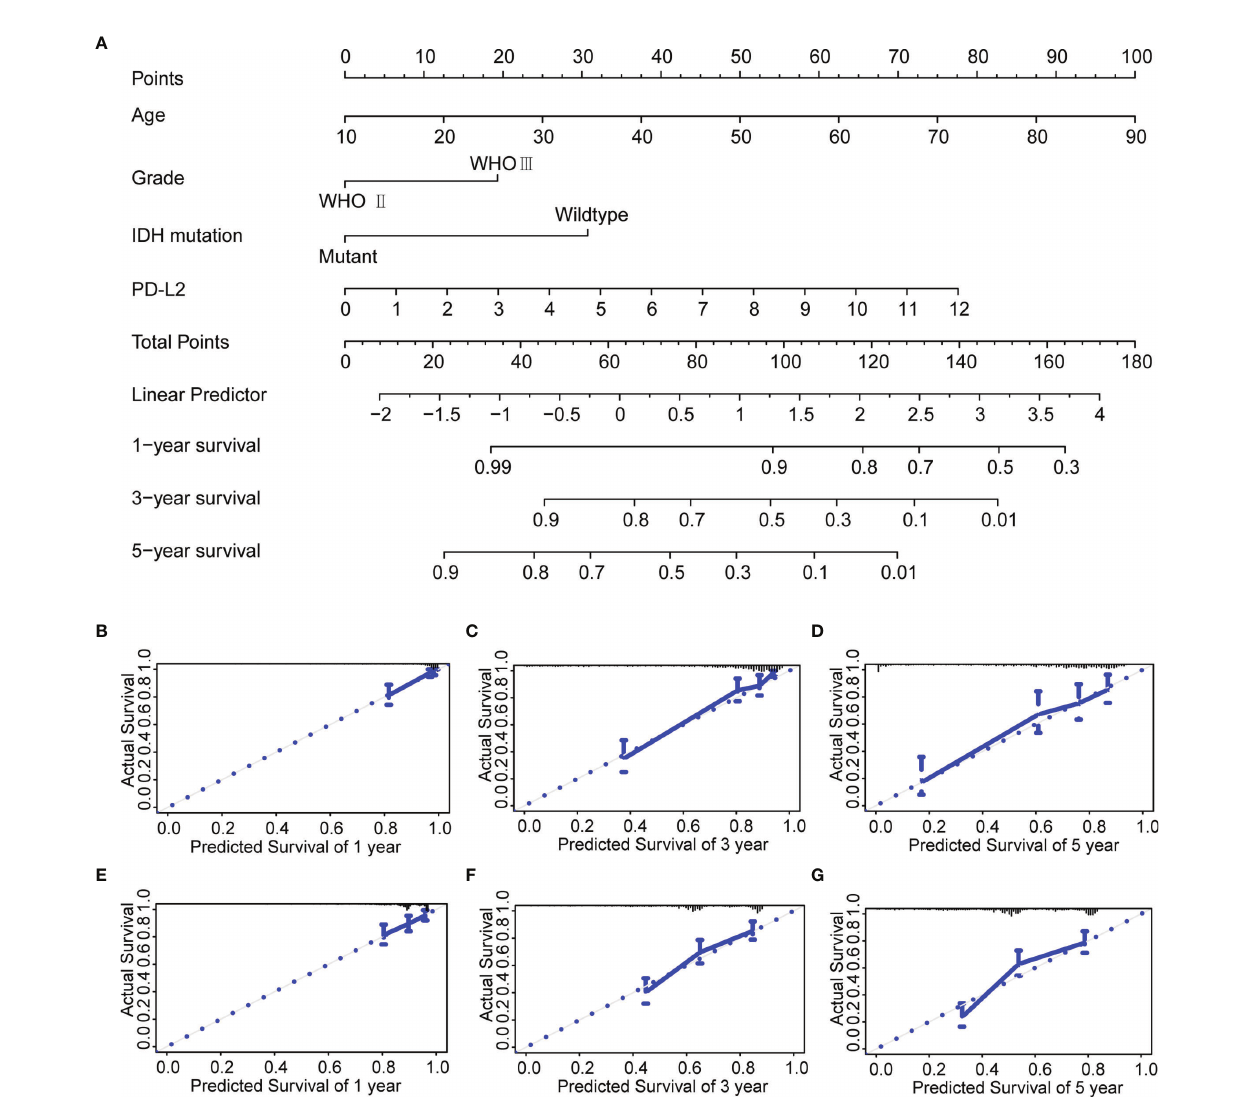
FIGURE 4 | Construction and evaluation of a prognostic nomogram. (A) The prognostic nomogram predicts the probability of the 1-, 3-, and 5-year OS. (B – D) The calibration curve of the nomogram for predicting the 1-, 3-, and 5-year OS in the TCGA database. (E – G) The calibration curve of the nomogram for predicting the 1-, 3-, and 5-year OS in the CGGA